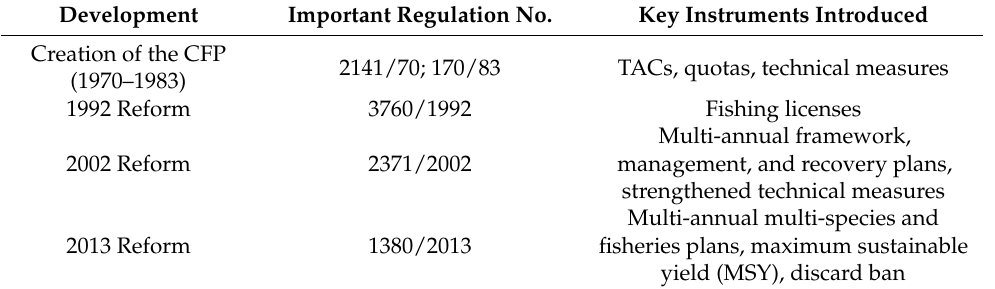
Table 4. Development of the